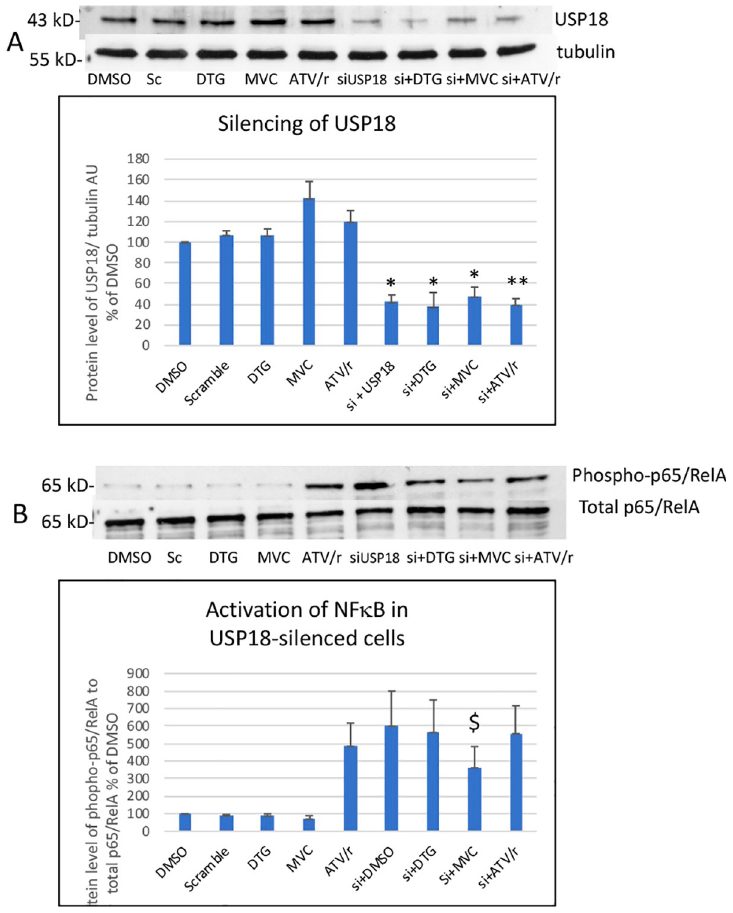
Fig 5. Effect of USP18 silencing on the level of the USP18 protein (A) and on the ability of DTG, MVC and ATV/r to modulate NF κ B activation (B) A representative Western blot of USP18 and tubulin as a loading control is shown in A and of phospho-p65/RelA and total p65/RelA to evaluate NF κ B activation in B. The histograms represent the mean+/-SEM value as compared to the DMSO control set at 100% of 3 independent experiments. Si-DMSO: control silenced for USP18, Si-DTG: DTG-treated cells silenced for USP18, Si-MVC: MVC-treated cells silenced for USP18, Si-ATV/r: ATV/r-treated cells silenced for USP18 The comparisons used Welch’s correction of Student T-test. � p < 0.05 �� p < 0.01 versus control (DMSO) $ p < 0.05 versus Si-DMSO.